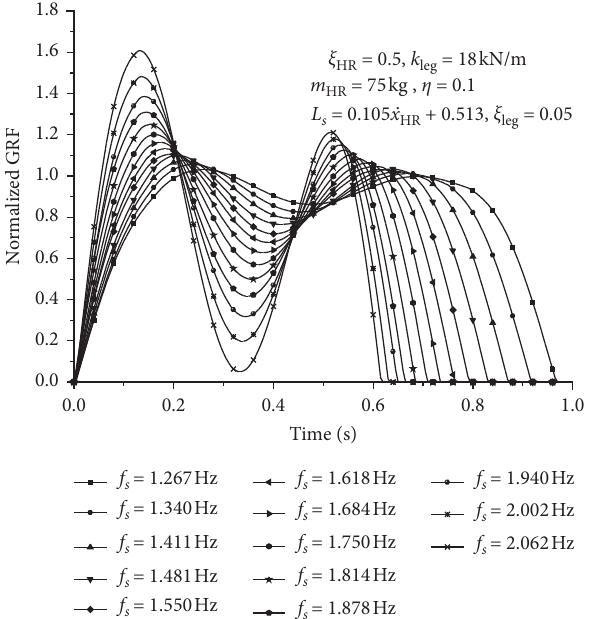
Figure 36: Normalized GRF under different gait